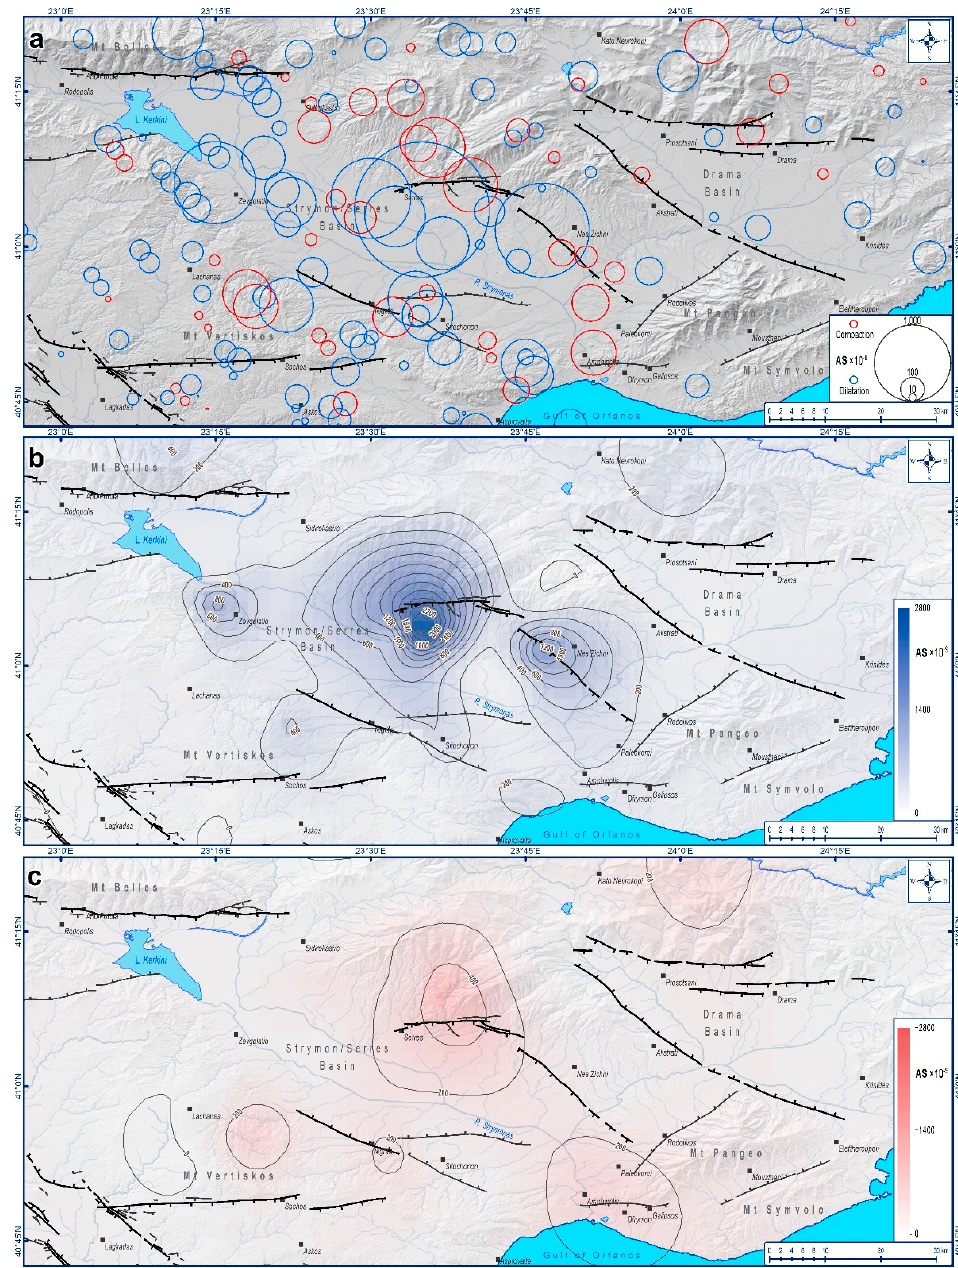
Figure 7. Area Strain (AS) in the broader Strymon area: ( a ) calculated dilatation (blue circles) and compaction (red circles) values; ( b ) dilatation values grid, based on the interpolation (kriging) geostatistical methodology; ( c ) compaction values grid, based on the interpolation (kriging) geostatistical methodology.